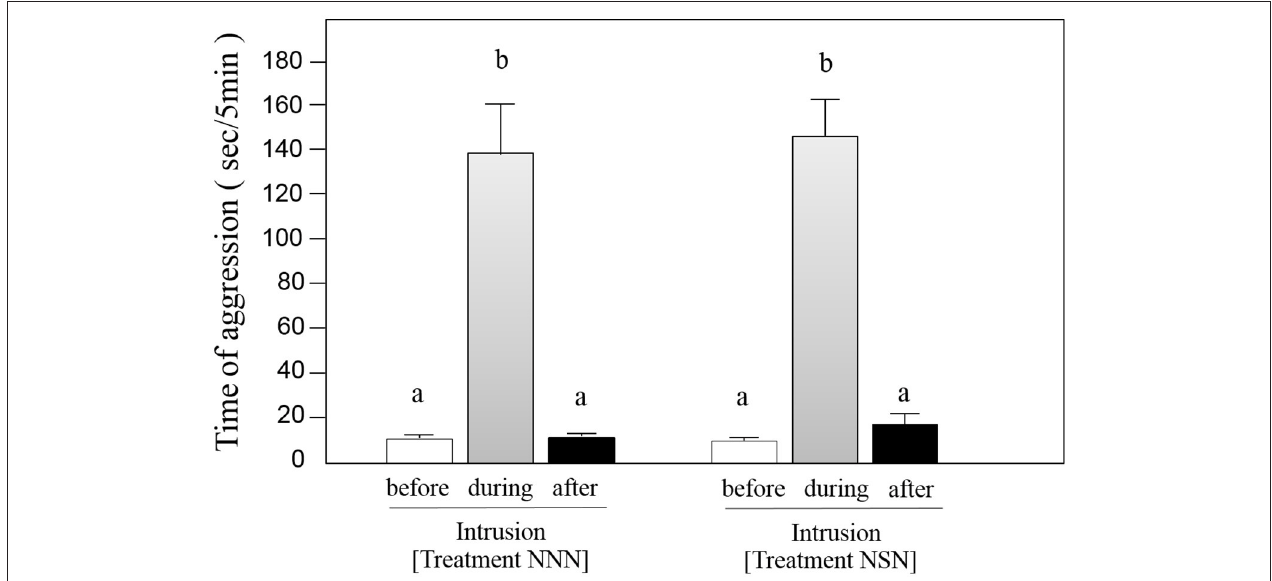
FIGURE 2 | Aggressive responses of focal fish toward exhibited fish in Treatments NNN and NSN. Average duration ( ± SE, n = 8) of aggressive behavior by the focal fish against a neighbor before (open bar) and after (solid bar) a 5-min intrusion of the neighbor or a stranger (gray bar). The different letters above the bars denote differences at P <